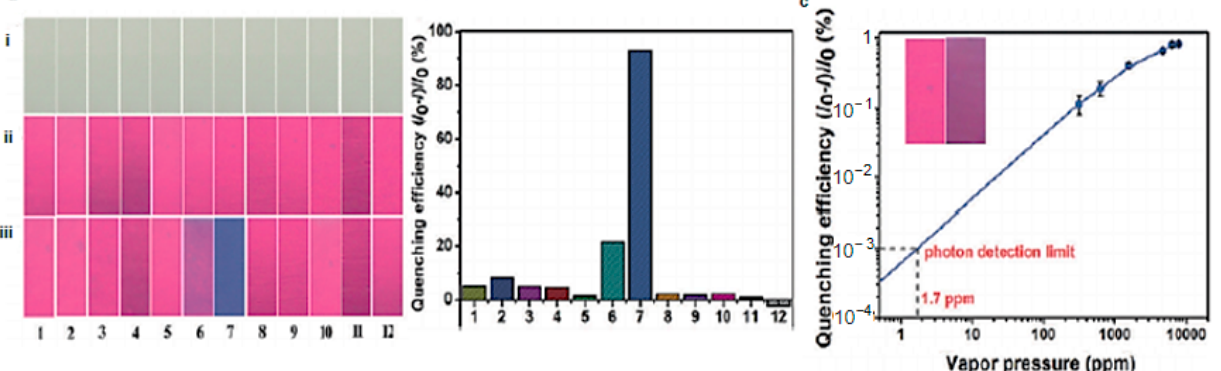
Figure 13. ( a ) Images of PVDF/C-dot membranes under visible light (i) and before (ii) and after (iii) exposure to saturated vapours of various solvents with a response time of 30 s ( λ ex = 365 nm): 1, acetonitrile; 2, o-nitrotoluene; 3, toluene; 4, cyclo- hexylamine; 5, hydrazine; 6, ethanediamine; 7, ammonia; 8, dimethyl sulfoxide; 9, acetic acid; 10, acetone; 11, chloroform; 12, hydrochloric acid. ( b ) Quenching efficiency in the presence of molecules 1–12. ( c ) Quenching efficiency as a function of vapour pressure of ammonia. Inset: Images of the PVDF/C-dots before ( left ) and after ( right ) exposure to 310 ppm of ammonia with a response time 30 sec ( λ ex = 365 nm). Reprinted (adapted) with permission from [82]. Copyright 2021 John Wiley and